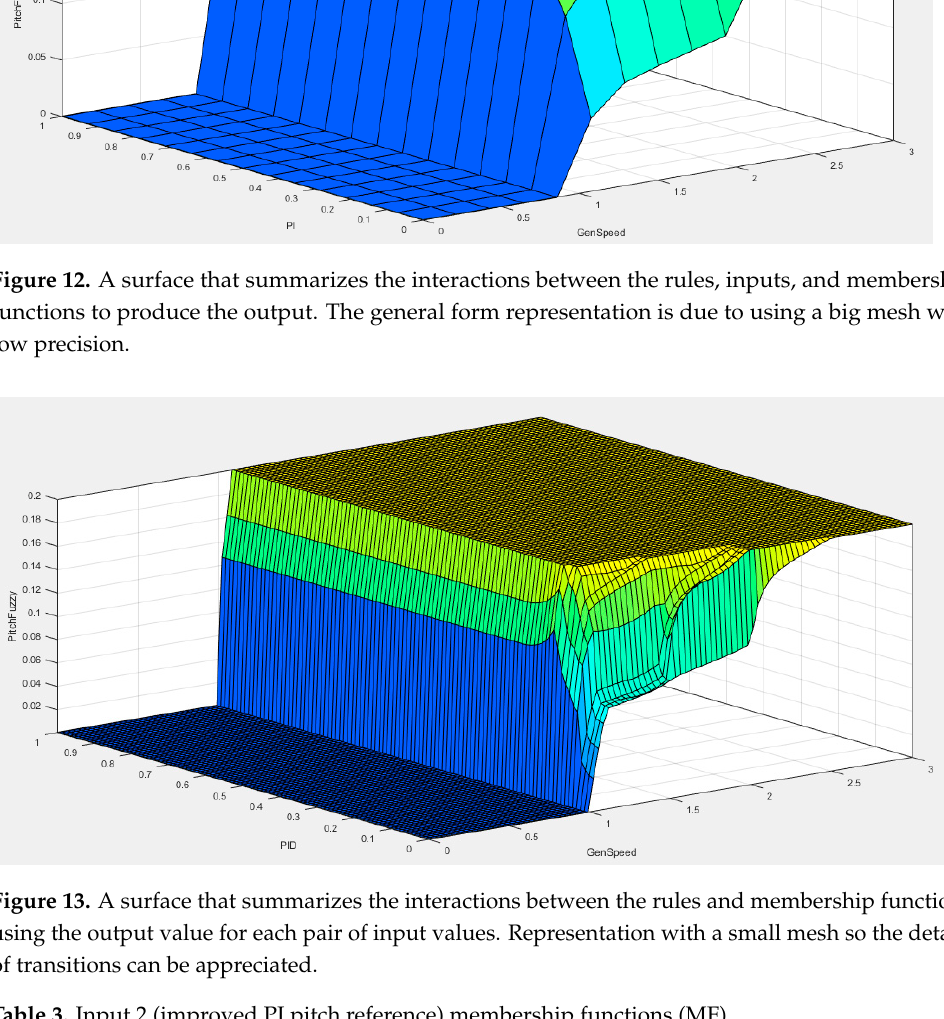
Table 2. Input 1 (generator speed) membership functions (MF). Table 3. Input 2 (improved PI pitch reference) membership functions